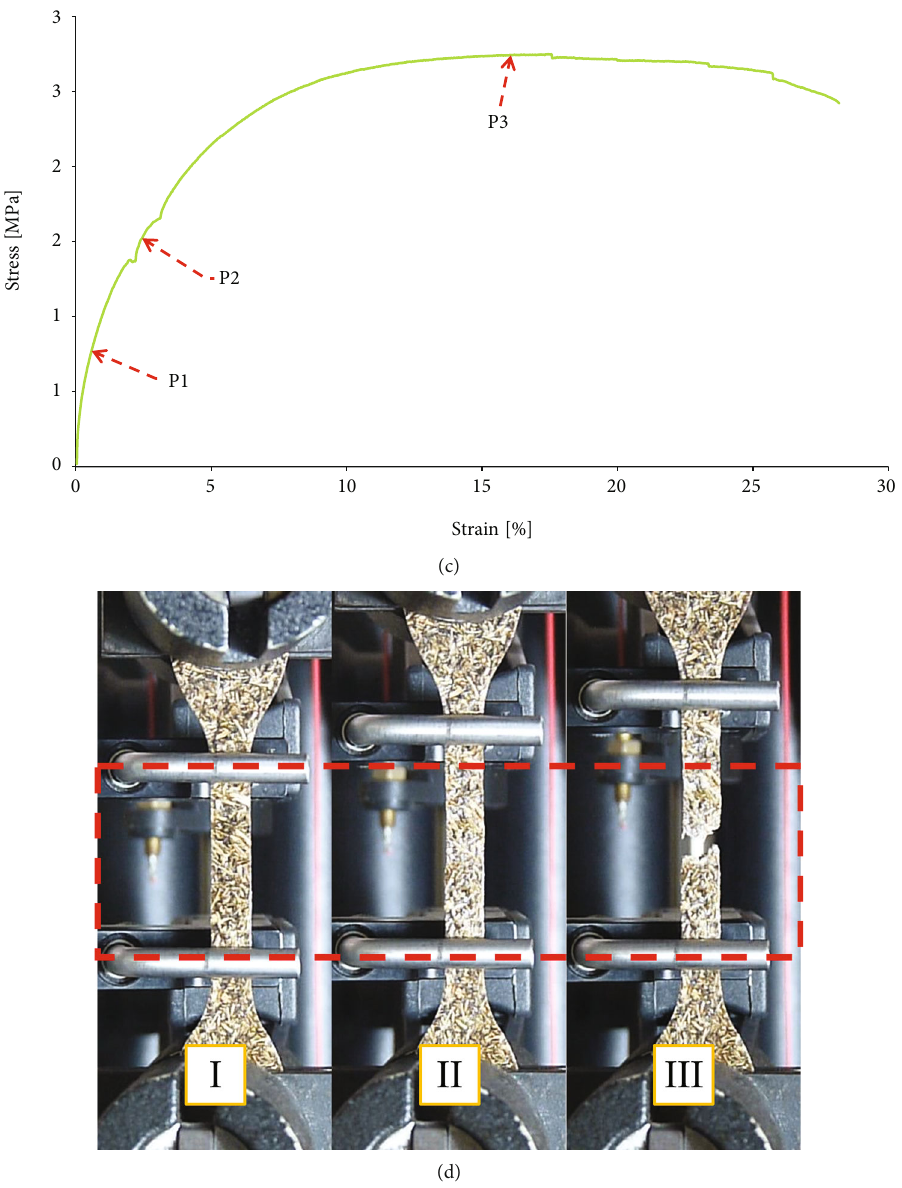
Figure 5: Tensile stress-strain behavior of (a) acrylic thermoplastic matrix, (b) OPEFB fi ber, (c) OPEFB/acrylic thermoplastic composite, and (d) tensile specimen under test: (I) before, (II) during, and (III)